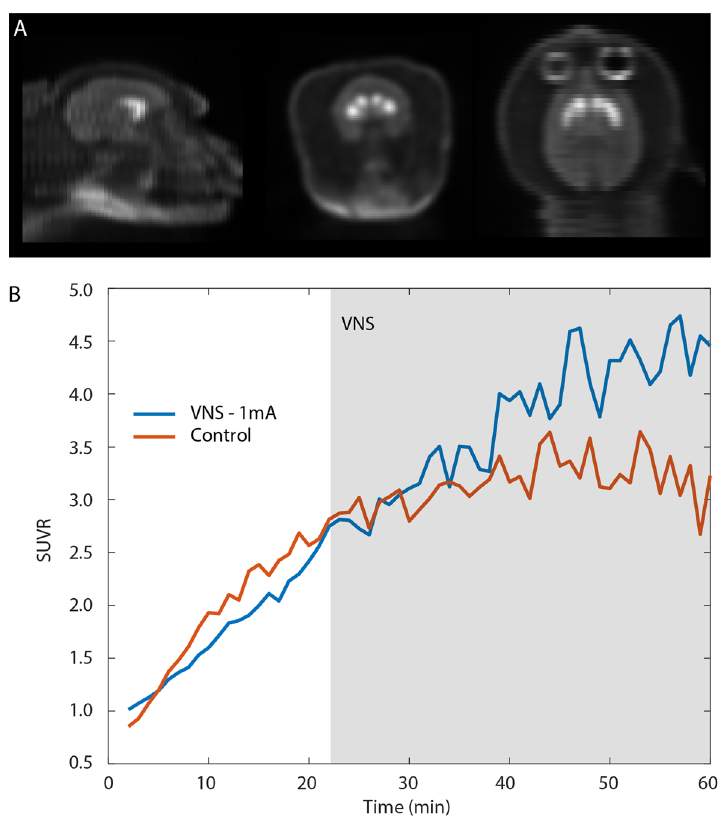
Fig. 6 Assessment of neurochemical activity via PET. A Sagital, coronal and axial (left to right) PET images illustrating [ 11 C]Raclopride, a selective antagonist on D2 dopamine receptors, uptake in the brain of one NHP. Consistent with its higer densisty of dopaminergic terminals, the striatum appears brighter than other regions demonstrating higher concentrations of the PET tracer. B Time activity curves for [ 11 C]Raclopride within the striatum for VNS (blue) and control (orange) conditions. VNS increased binding of the tracer indicating a decrease of endogenous dopamine compared to